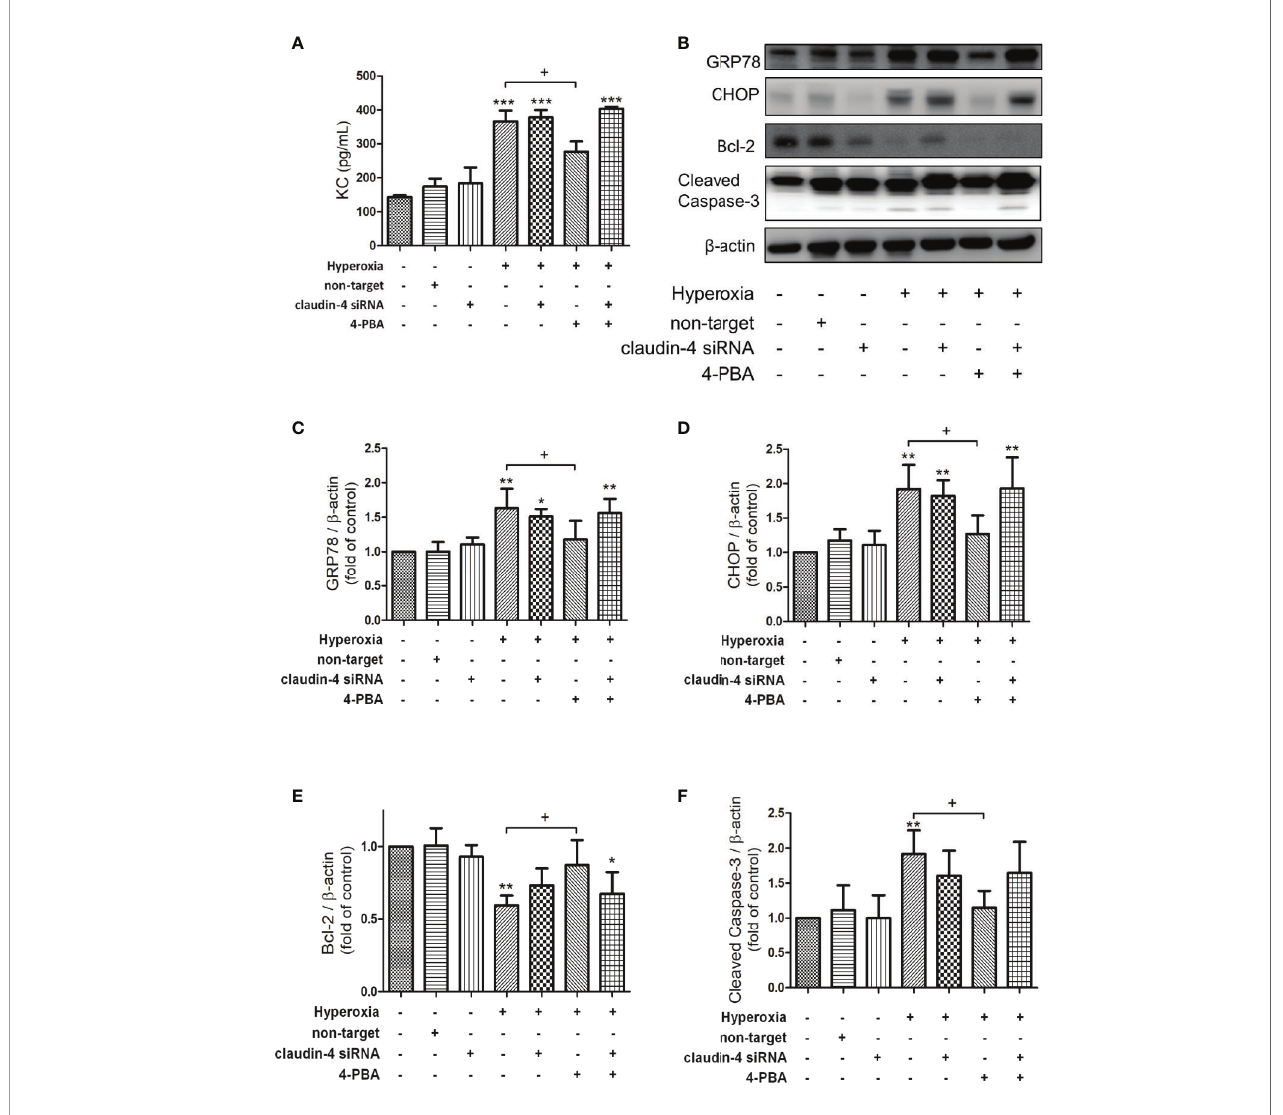
FIGURE 8 | Claudin-4 knockdown blunts the bene fi cial effects of 4-PBA in KC production, GRP78 and CHOP protein expression, and apoptosis in hyperoxia- exposed MLE-12 cells. (A) KC in BALF was measured by ELISA. (B) Western blot analysis of GRP78, CHOP, Bcl-2, and cleaved caspase-3 expression in MLE-12 cells. Relative expressions of GRP78 (C) , CHOP (D) , Bcl-2 (E) , and cleaved caspase-3 (F) in MLE-12 cells were shown. Data are mean ± SDs, each experiment was performed at least independently in triplicate, *p < 0.05, **p < 0.01, ***p < 0.001 compared with the control group, + p < 0.05, compared with the hyperoxia